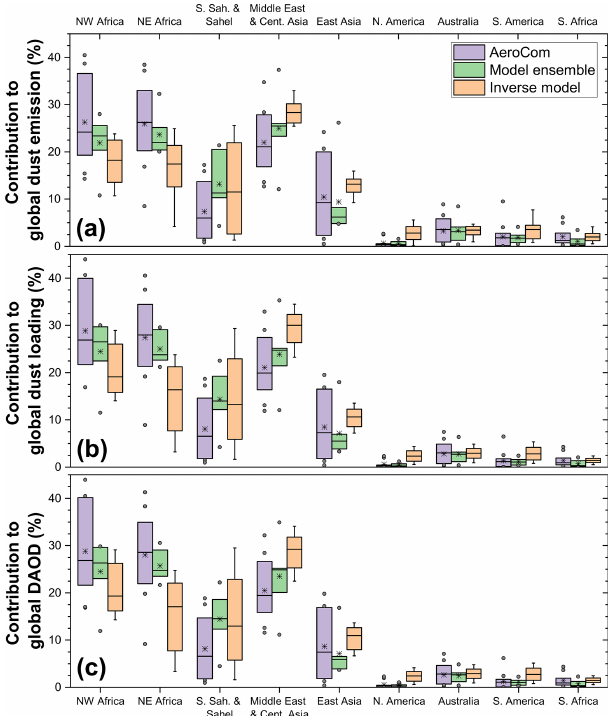
Figure 2. Fractional contribution of each source region to the global dust cycle. Shown are the fractional contributions to the annual global dust emission (and deposition) flux (a) , the global dust load- ing (b) , and the global DAOD (c) for the AeroCom ensemble (pur- ple boxes; see Sect. 2.2), our model ensemble (green boxes), and for the inverse model (orange boxes). Box boundaries approximately denote the one standard error range (i.e., boxes contain 9 out of 13 AeroCom simulations, 4 out of 6 model ensemble members, and the 68% probability range for the inverse model results), gray circles denote the individual simulation results outside this range, whiskers denote the 95% confidence interval for the inverse model results, horizontal solid lines denote the median result, and stars denote the mean result. Results for each season are shown in Figs.